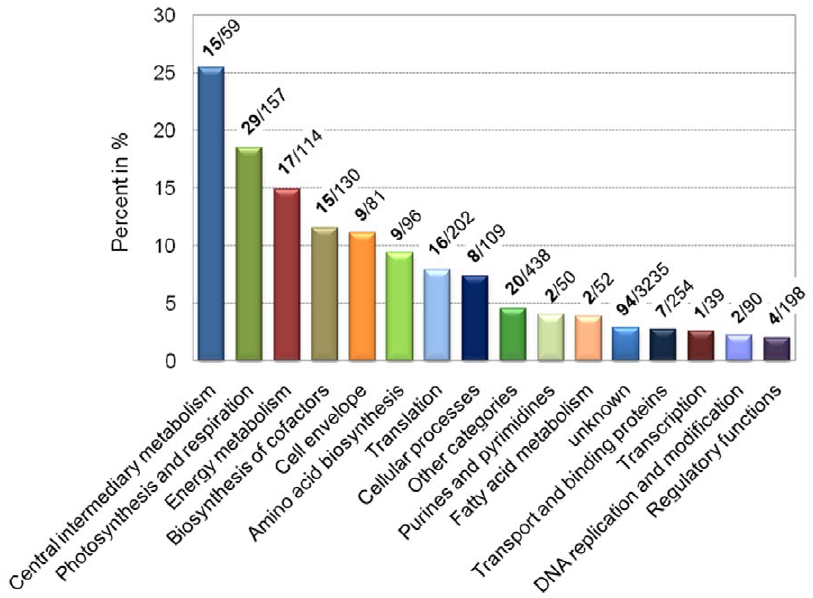
Figure 2. Functional category breakdown for all cyclic proteins. The graph shows the percentage of cyclic proteins within each functional category, calculated based on the total number of predicted proteins in each functional category. The number of cyclic proteins vs . the total number of proteins from each functional category is shown in bold. Functional categories for each gene are assigned as [6].